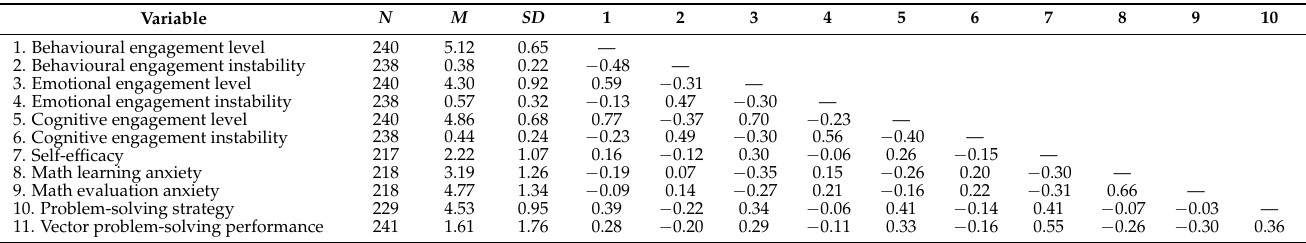
Table 5. Descriptive statistics and correlation